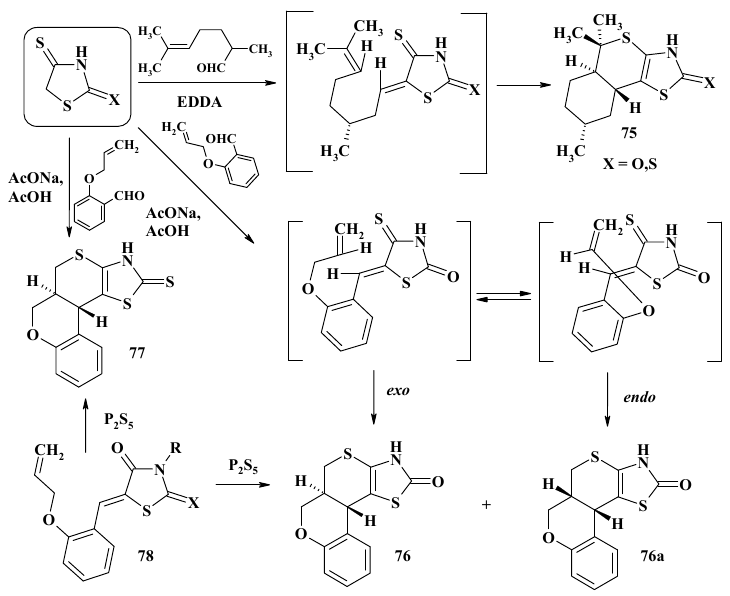
Scheme 26. Features of domino Knoevenagel- hetero -Diels–Alder reaction. The NH-acidic center of the basic core of the compound 76 predetermined its further transformations (Scheme 27) through the stage of potassium salt 79 formation with the following alkylation with chloroacetamides, bromoacetophenones, ethyl chloroacetate that allowed obtaining new N -substituted derivatives 80 – 82 [55].